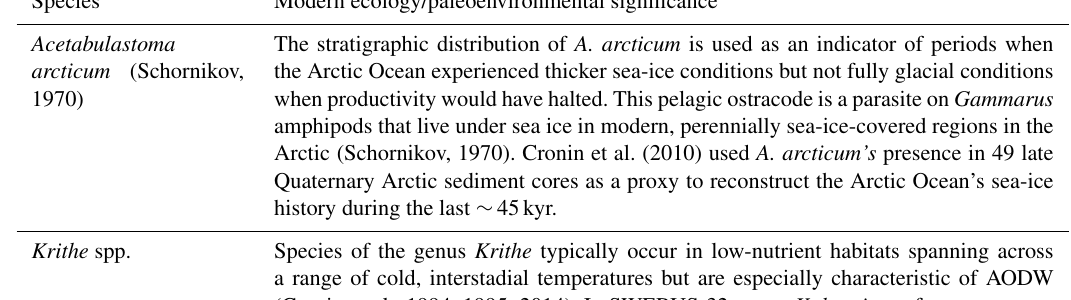
Table 4. Summary of indicator species, pertinent aspects of their modern ecology and paleoenvironmental significance. Species Modern ecology/paleoenvironmental significance